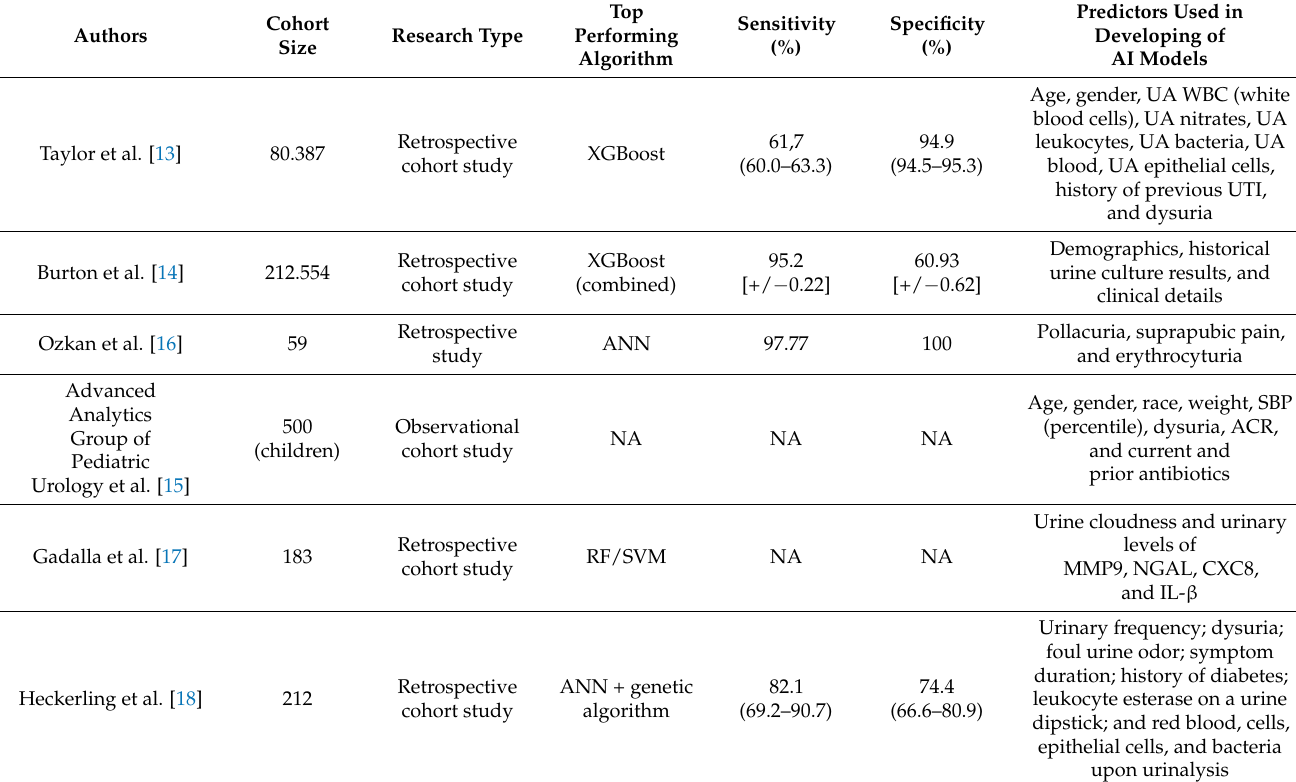
Table 1. An overview of the current knowledge regarding various AI models in UTI